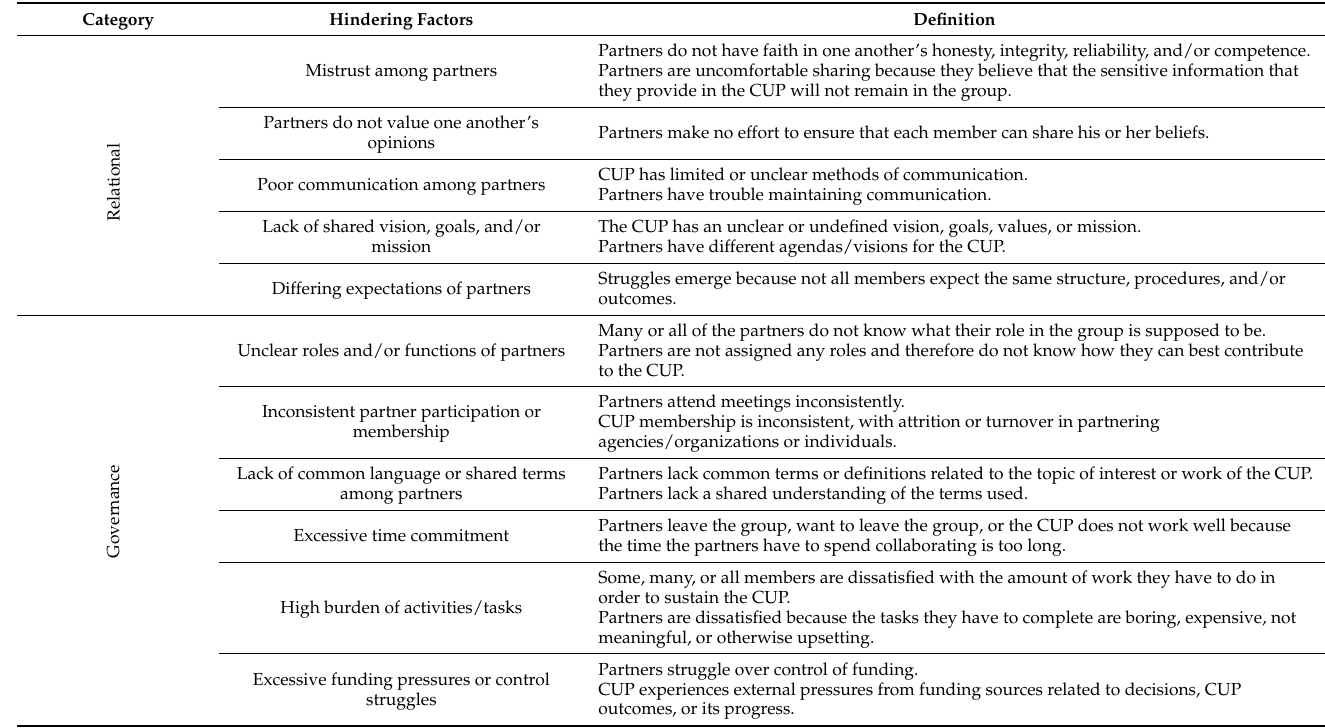
Table 2. Hindering factors of